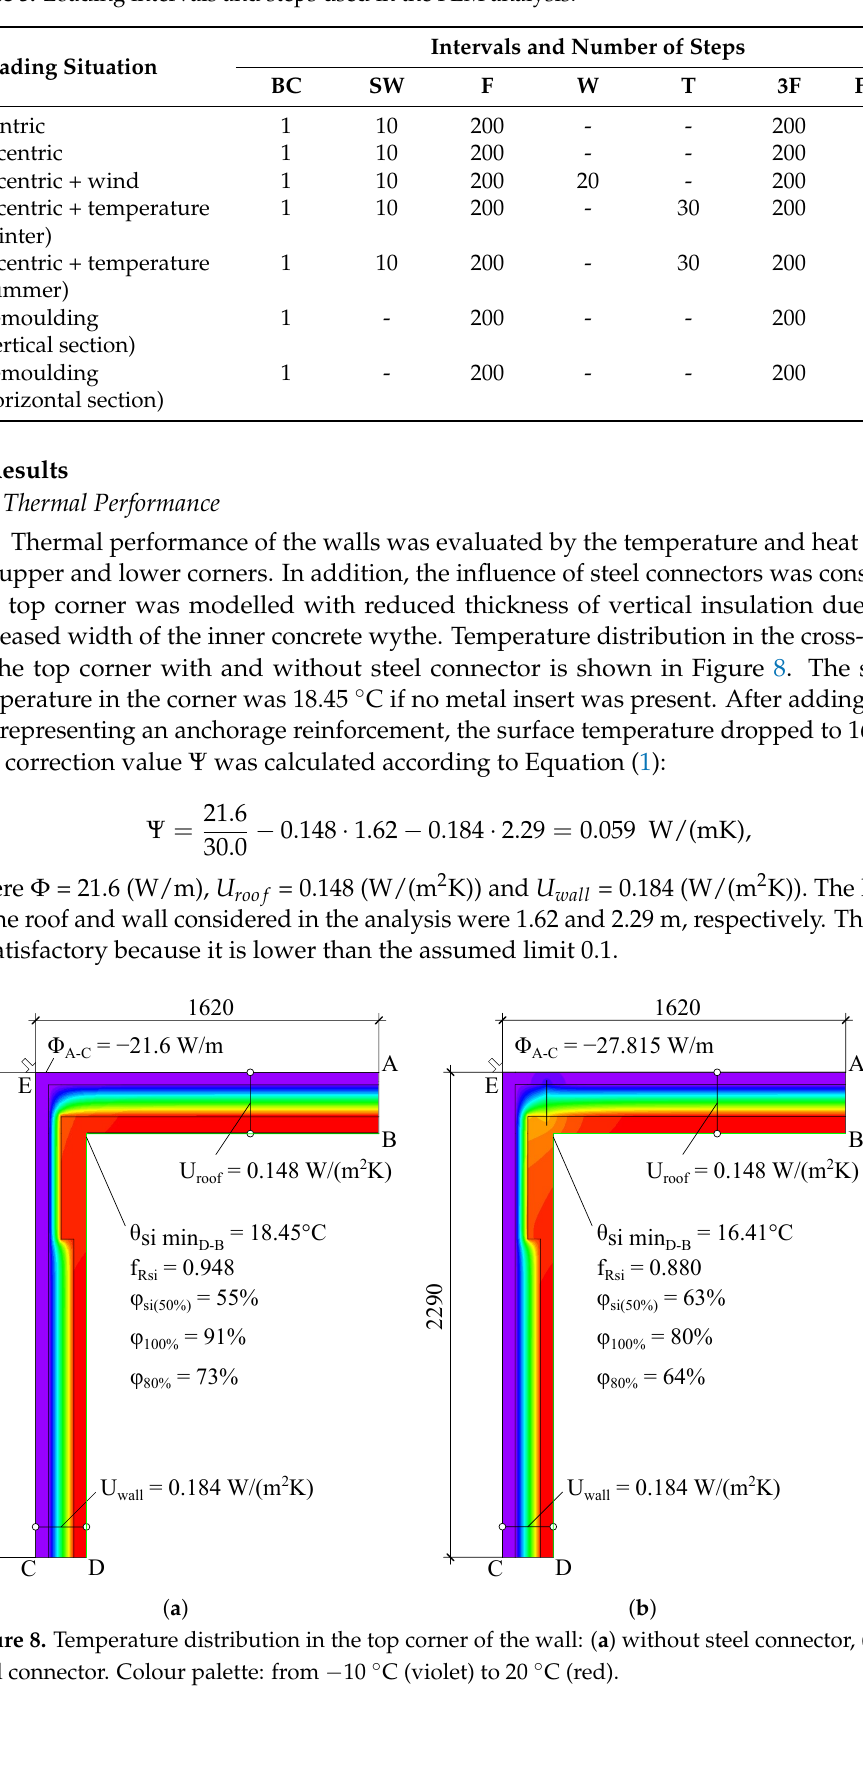
Table 5. Loading intervals and steps used in the FEM analysis.